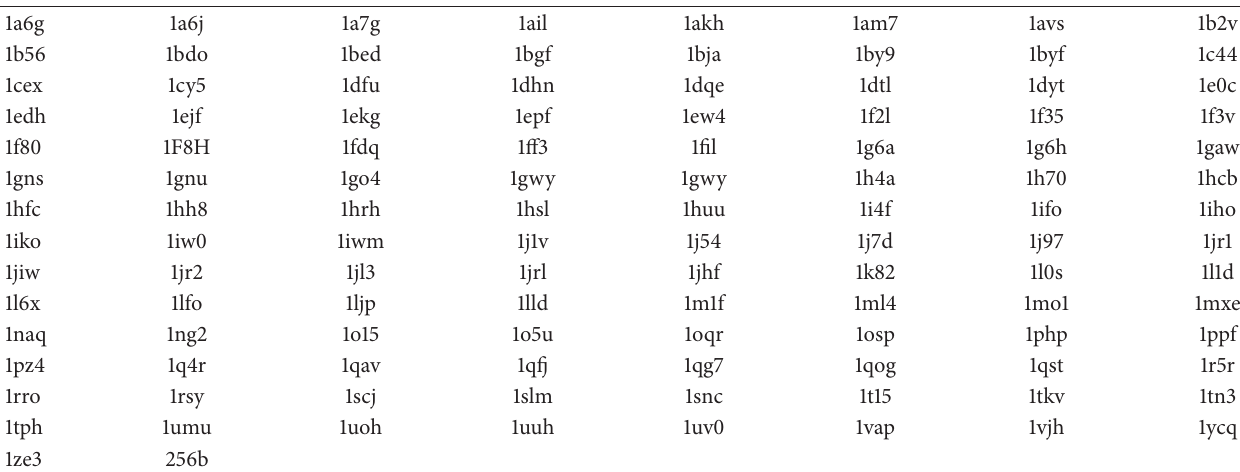
Table 3: PDB 114 chains used in this